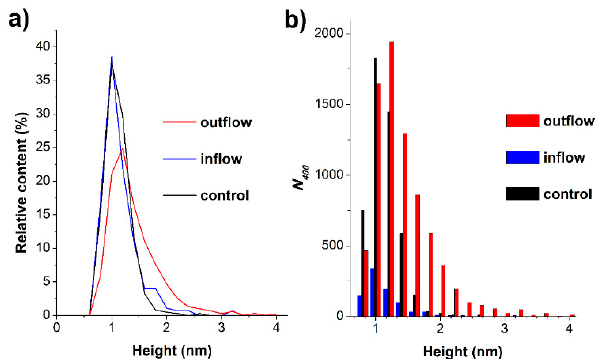
Figure 3. Results of processing of AFM data obtained for HRP solutions. ( a ) Typical plots of distribution of the imaged objects with height ρ ( h ). ( b ) Absolute number of AFM-visualized particles, normalized per 400 µm 2 . The cell with HRP solution was placed far away at a 10-m distance from the experimental setup (control experiment, black line and bars), near the inflow (blue line and bars) or near the outflow (red line and bars) section of the pipe.